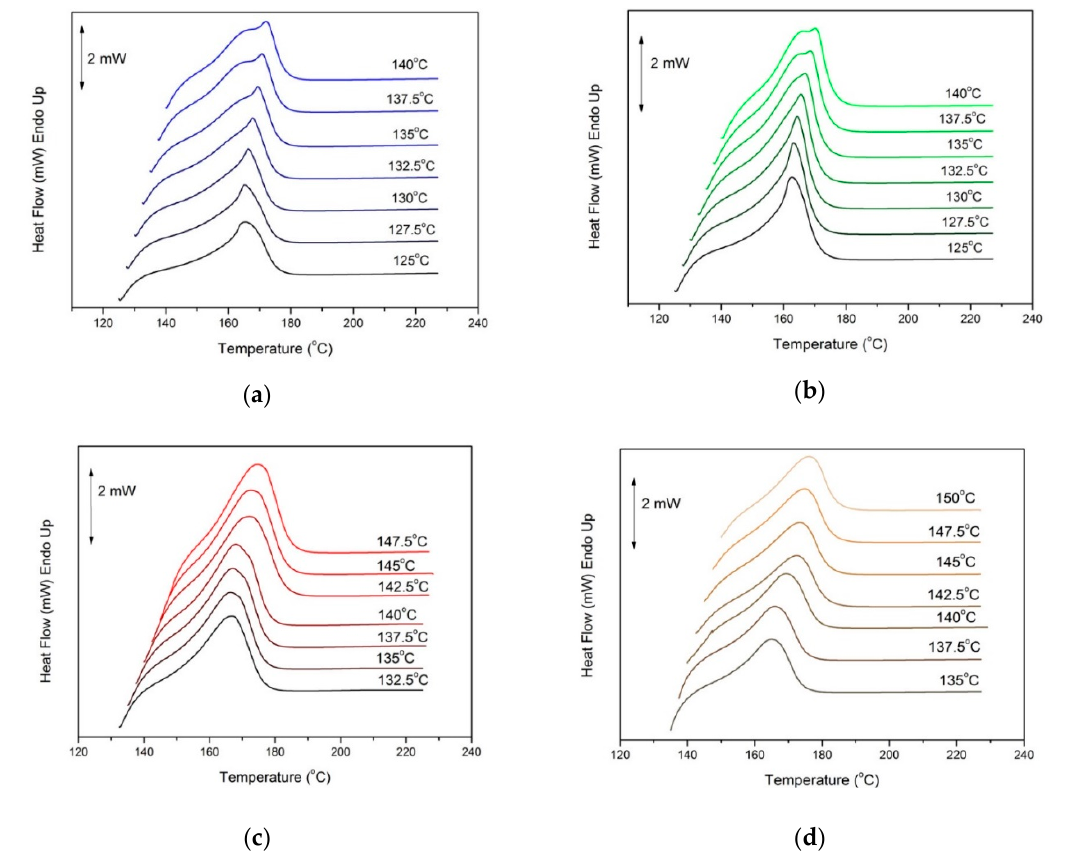
Figure 6. Melting traces of ( a ) PP, ( b ) PP–GF10, ( c ) PP–GNP5, and ( d ) PP–GF18–GNP10 composites after isothermal crystallization at various temperatures.